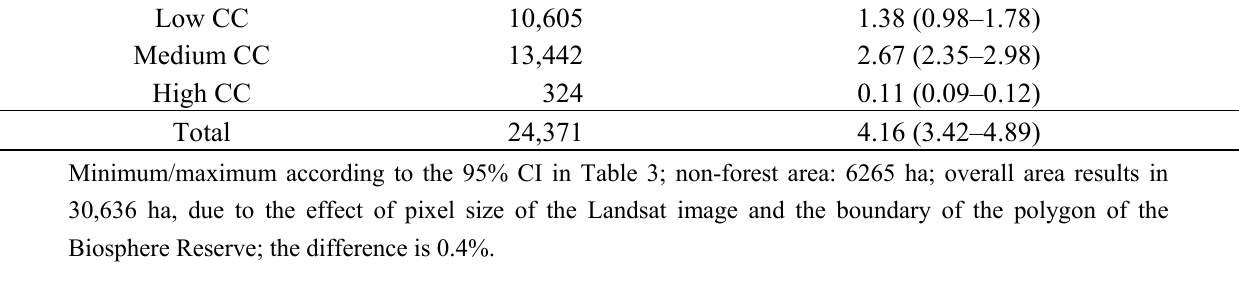
Table 4. Carbon content estimate in arboreal biomass in oak-pine mixed forest in La Primavera (mean values and 95% CI; values in MtCO